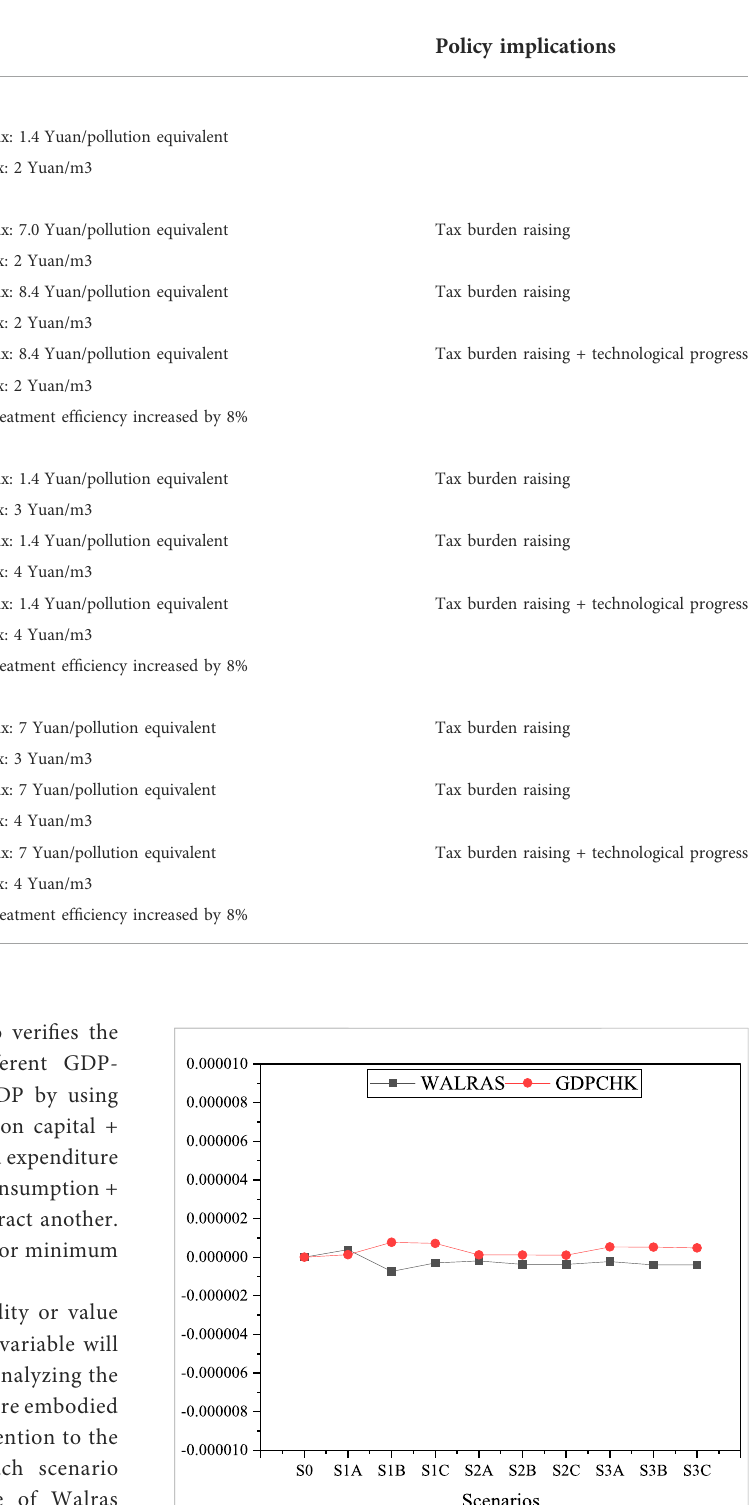
FIGURE 4 Values of WALRAS and